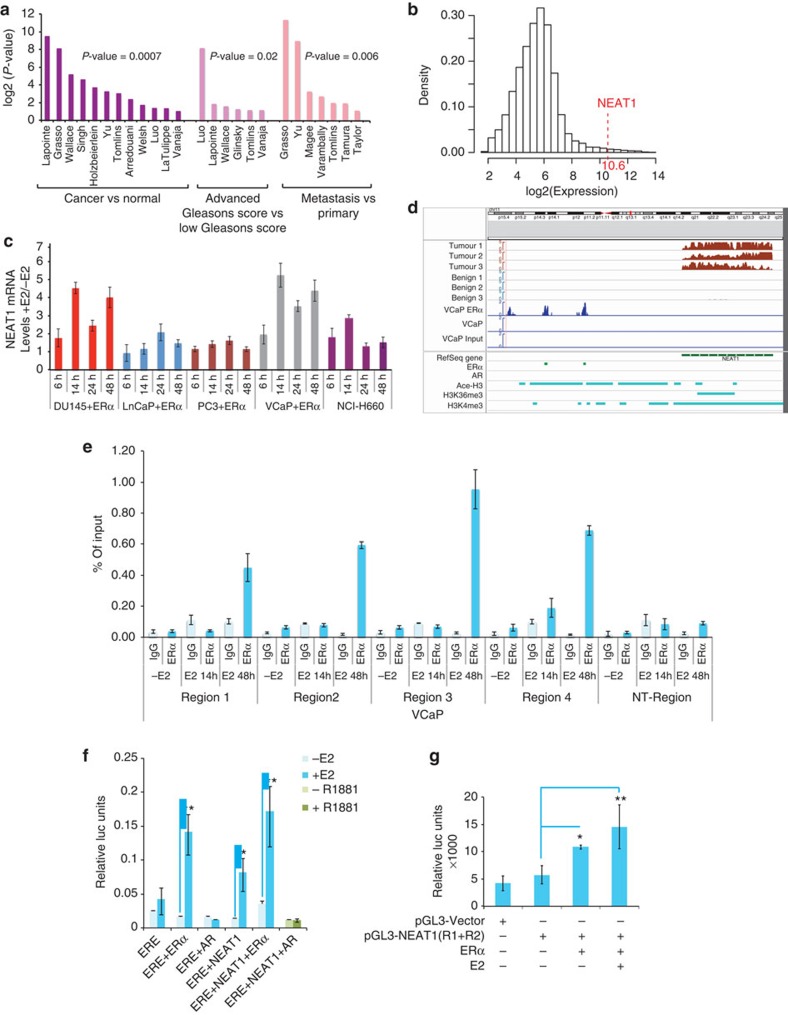
ERα regulated NEAT1 lncRNA is upregulated in prostate cancer.(a) NEAT1 is overexpressed in various prostate data sets (Oncomine). (b) Distribution of the median expression of all genes (core transcript clusters) on the Human Exon 1.0 ST array in the pooled Mayo Clinic cohort (n=594). NEAT1’s expression ranks in the 99th percentile of all genes on the array. (c) Expression of NEAT1 with/without ERα overexpression and E2 treatment (10 nM) at different time points in a panel of prostate cancer cell lines. Results are expressed as the mean±s.d. of three independent experiments. (d) View of NEAT1 genomic location indicates presence of two ERα-binding sites in the promoter region. Read coverage tracks derived from RNA-sequencing data indicates a higher abundance of NEAT1 transcripts in PCa compared with benign tumours in three representative cases. The figure also reports the ChIP-sequencing coverage tracks for ERα (VCaP ERα, VCaP and input DNA as control). The bottom panel shows the binding sites of ERα, AR (GEO Accession GSM353651-tissue AR (ref. 25)), Ace-H3, H3K4me3 and H3K36me3 in VCaP cell line (GEO Accession GSM353629, GSM353620 and GSM353624 (ref. 25)), respectively. (e) Chromatin immunoprecipitation followed by qPCR to study ERα recruitment to NEAT1 promoter in VCaP cells with/without E2 treatment (10 nM) was performed with primers spanning the binding regions identified by ERα ChIP-seq data. Primers for nonspecific region were used as negative control for ChIP studies. Results are expressed as percentage of input from two independent experiments. Vertical error bars represent the range of data. (f) Luciferase-based promoter reporter assays was used to analyse effect of ERα and/or AR on ERE-Luc promoter in VCaP cells. Cells were transiently transfected with the (ERE)3-SV40-luc reporter plasmid and ERα, or AR-treated with/without E2 or R1881 (1 nM) for 48 h. Results are expressed as the mean±s.d calculated from three independent experiments. (g) Luciferase-based promoter reporter assays were used to analyse NEAT1 promoter activity following ERα expression −/+E2 (10 nM) for 24 h. Results are expressed as the means±s.d. calculated from three independent experiments. Student’s t-test was performed for comparisons where indicated, and *P<0.05 and **P<0.01 were considered statistically significant.